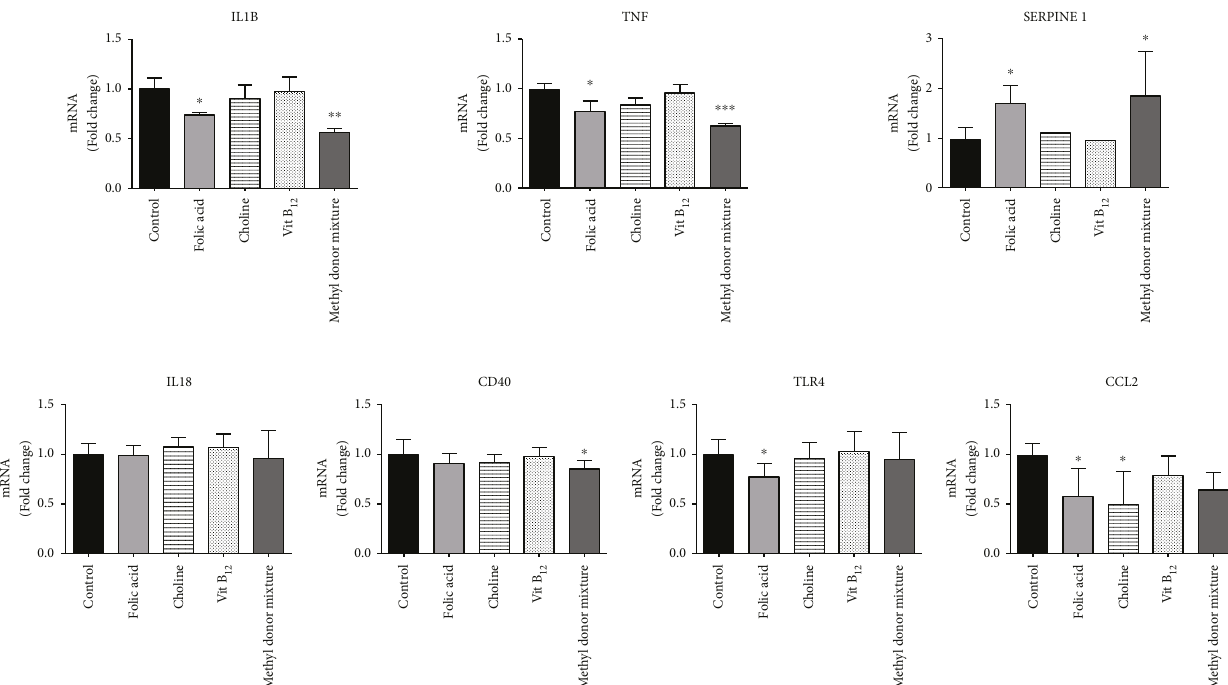
Figure 1: E ff ects of folic acid, choline, vitamin B , and the methyl donor mixture on the expression of in fl ammatory genes in THP-1 cells 12 treated with TPA and LPS. Results are expressed as means ± SD ( n = 8 ). Di ff erences between groups were analyzed by one-way ANOVA followed by Dunnett ’ s test. ∗ P value < 0.05, ∗∗ P value < 0.01, and ∗∗∗ P value < 0.001 versus